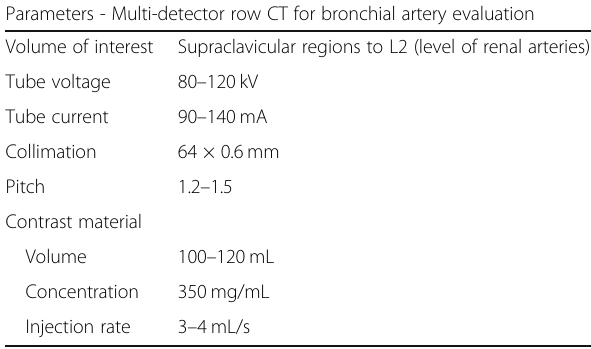
Suggested multi-detector row CT parameters for bronchial artery